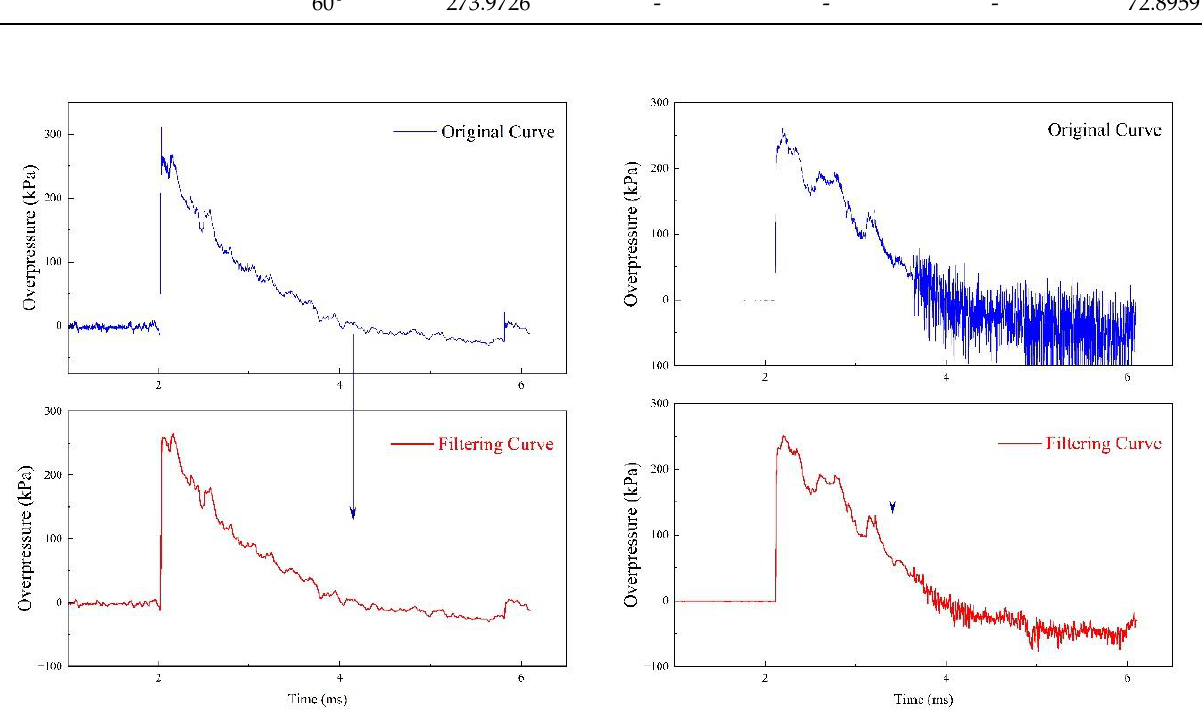
Figure 4. Original curves and filtered curves of the shock wave pressure.